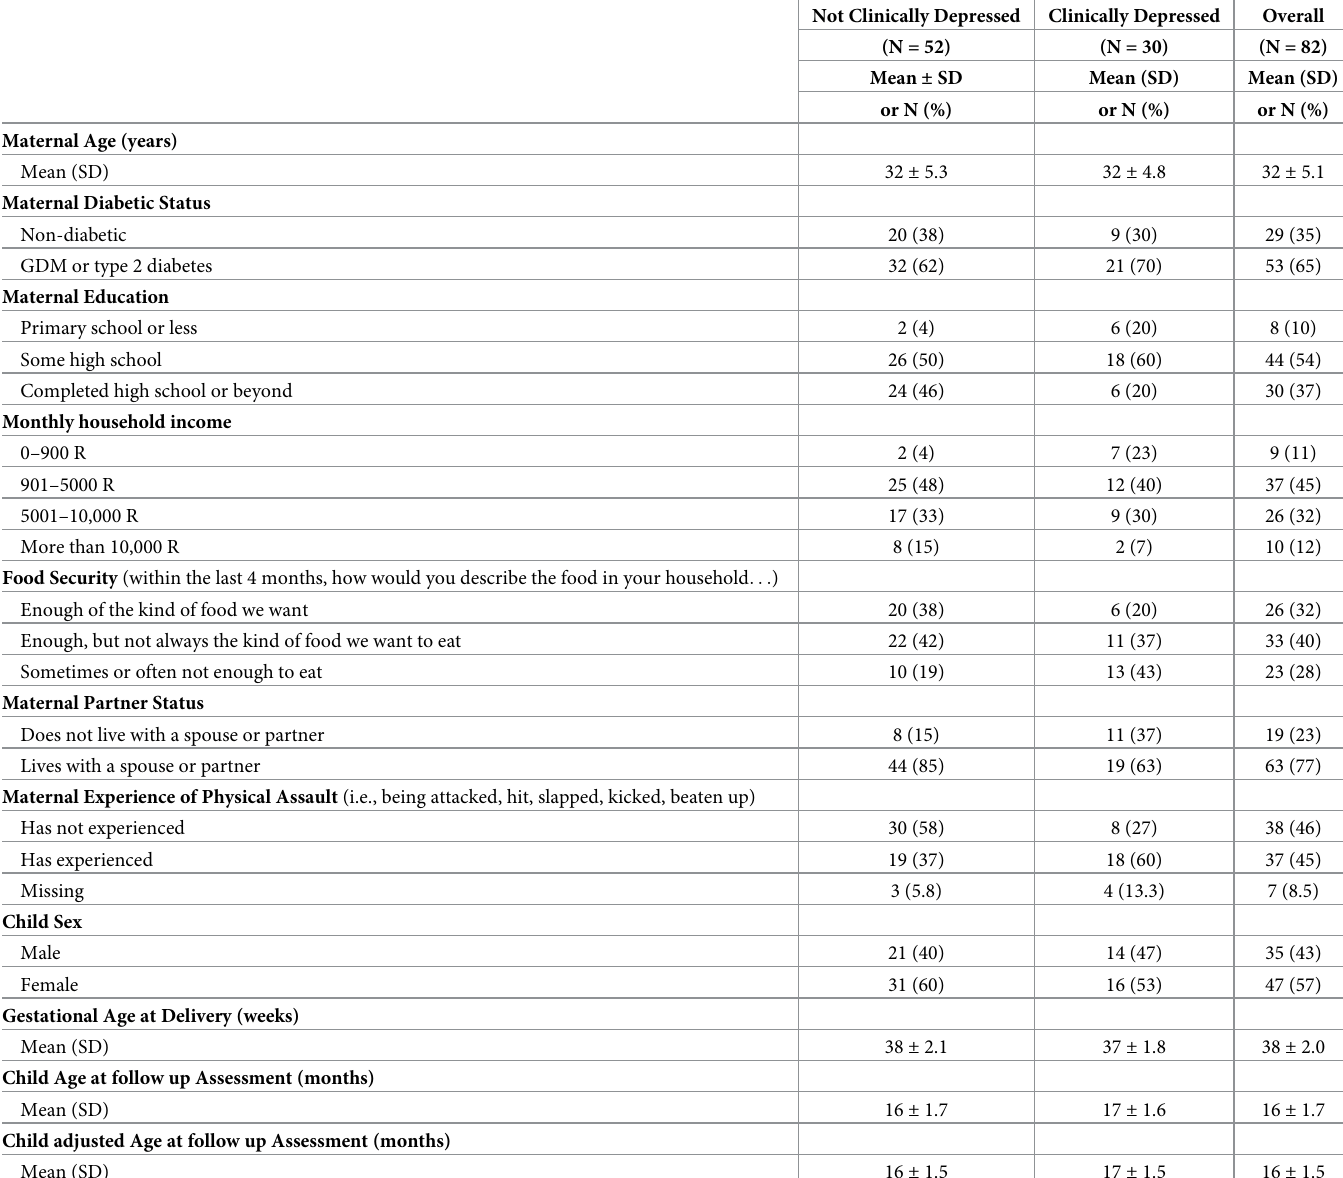
Table 2. Demographic characteristics of participants across depression